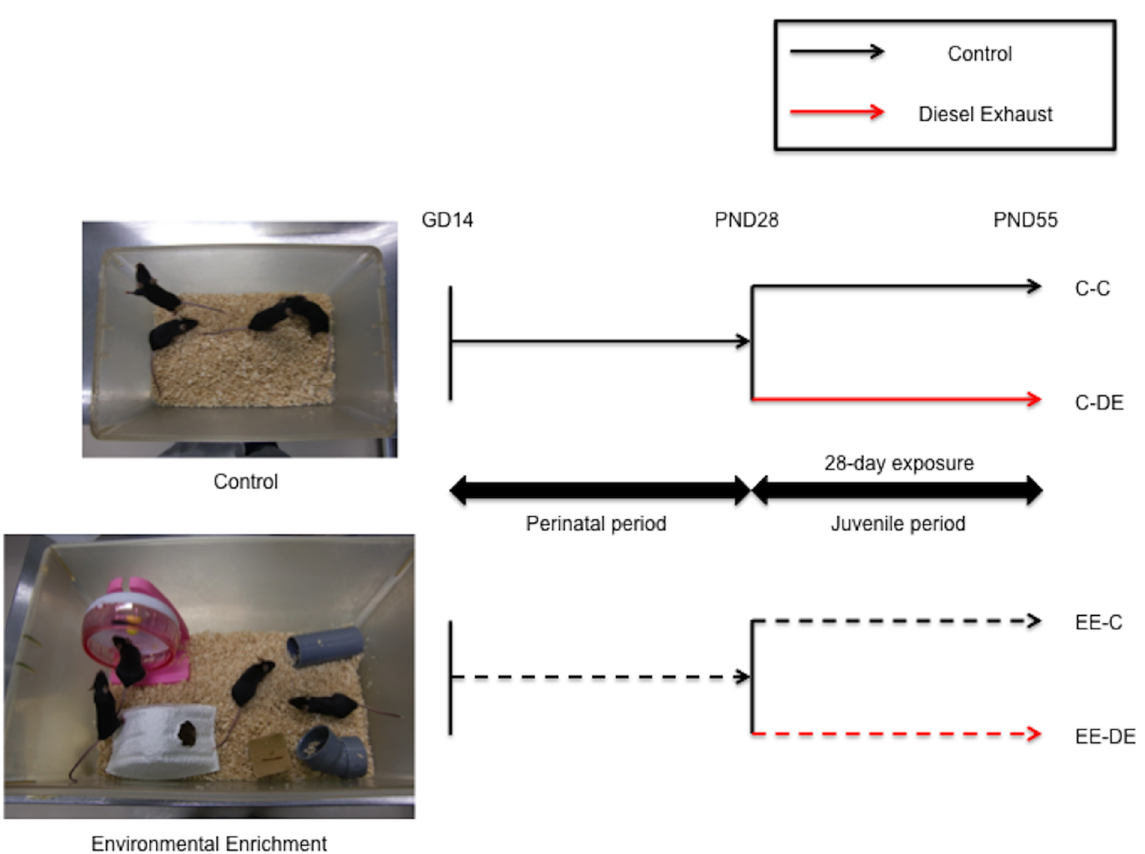
Figure 1. Schematic diagram of design of the present study.